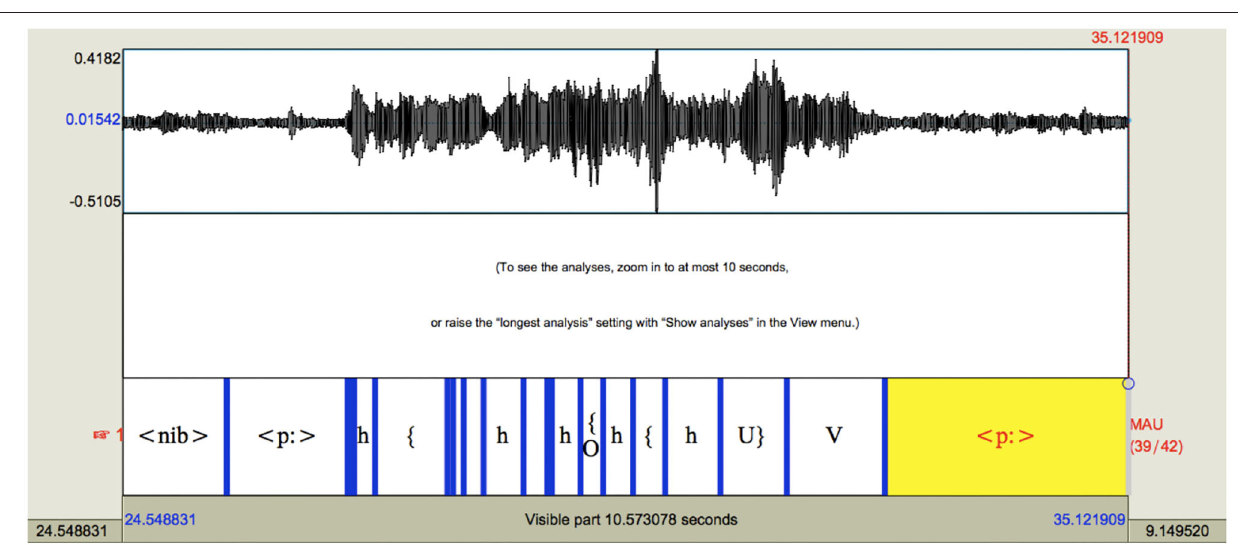
FIGURE 2 | Example 2 of system output with the poor quality recording using WEBMINNI,